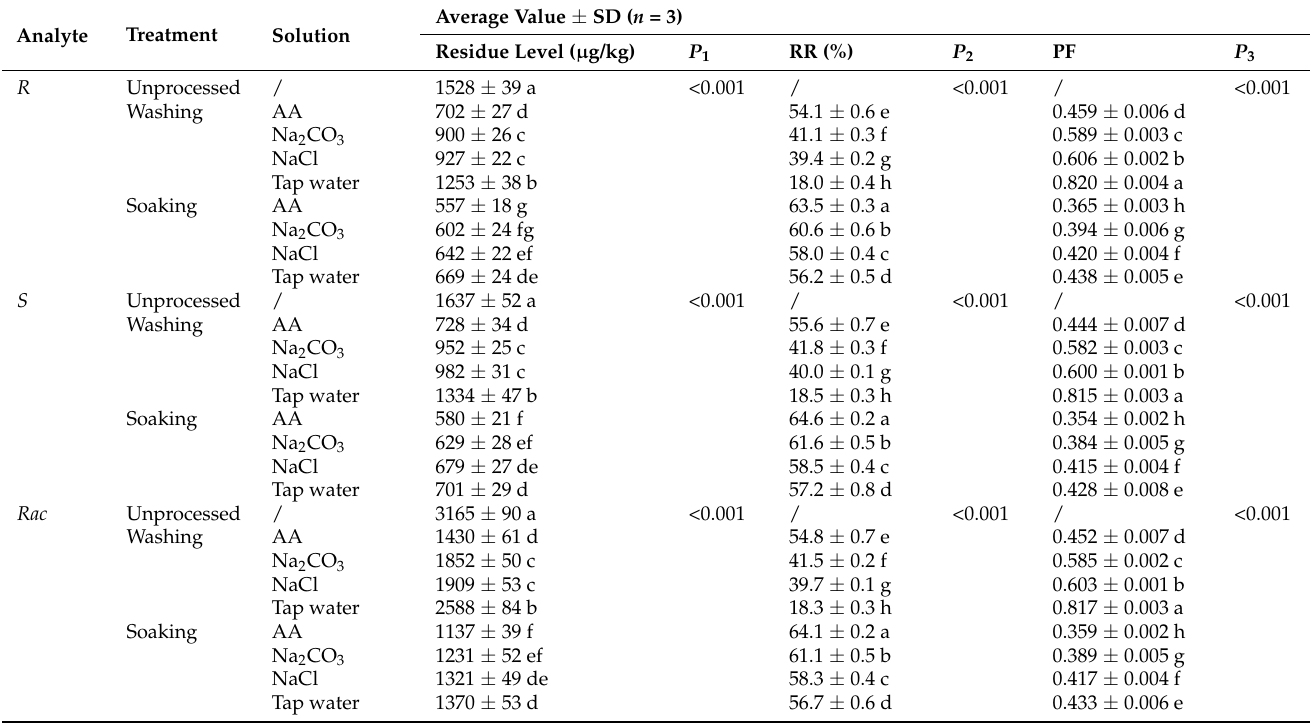
Table 4. Residue level, RR, and PF values of mandipropamid in unprocessed, washing, and soaking cowpea